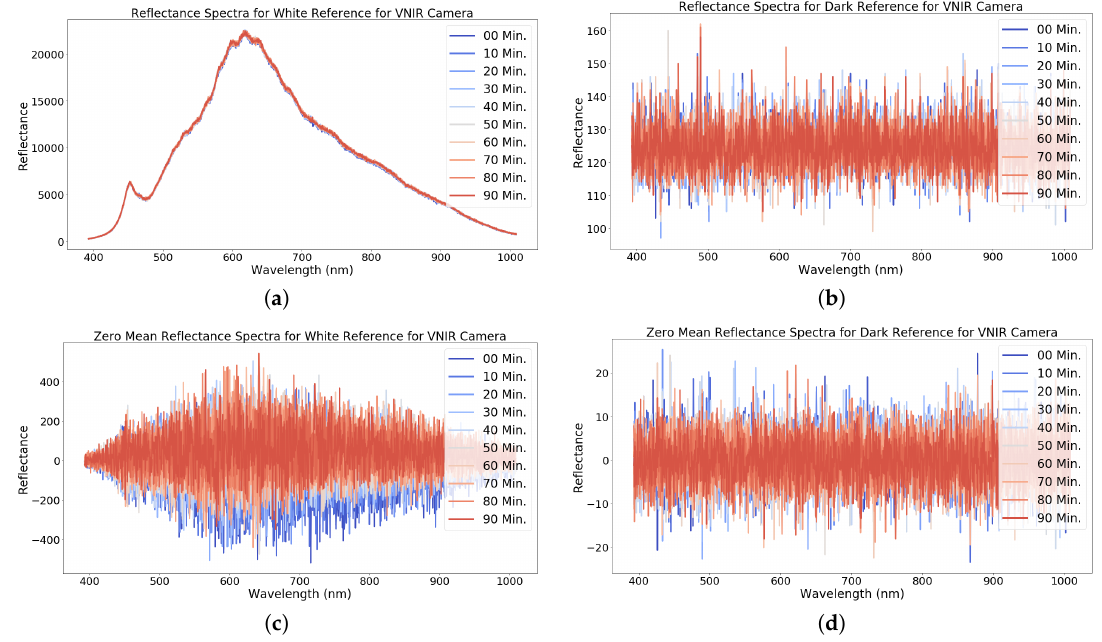
Figure 11. ( a ) White reference and ( b ) dark reference variability for a single pixel associated with the Optopolymer reference for a VNIR Camera. Zero mean reflectance for white reference ( c ) and dark reference ( d